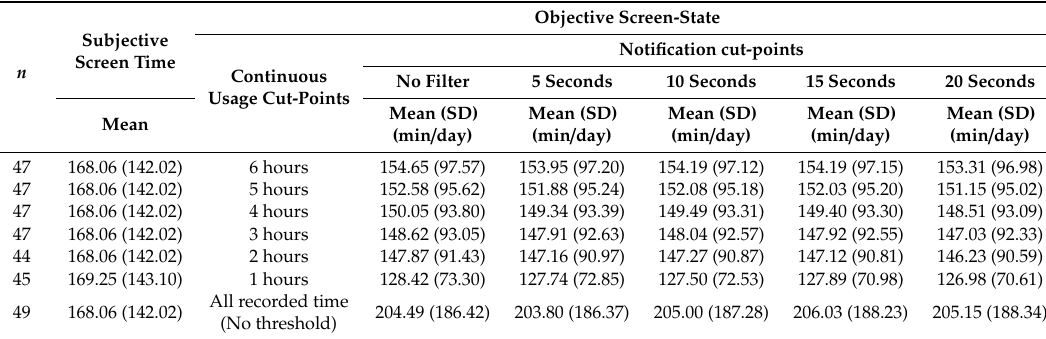
Table 2. Objective screen-state vs. subjective screen time on weekdays (minutes / day) ¥ .